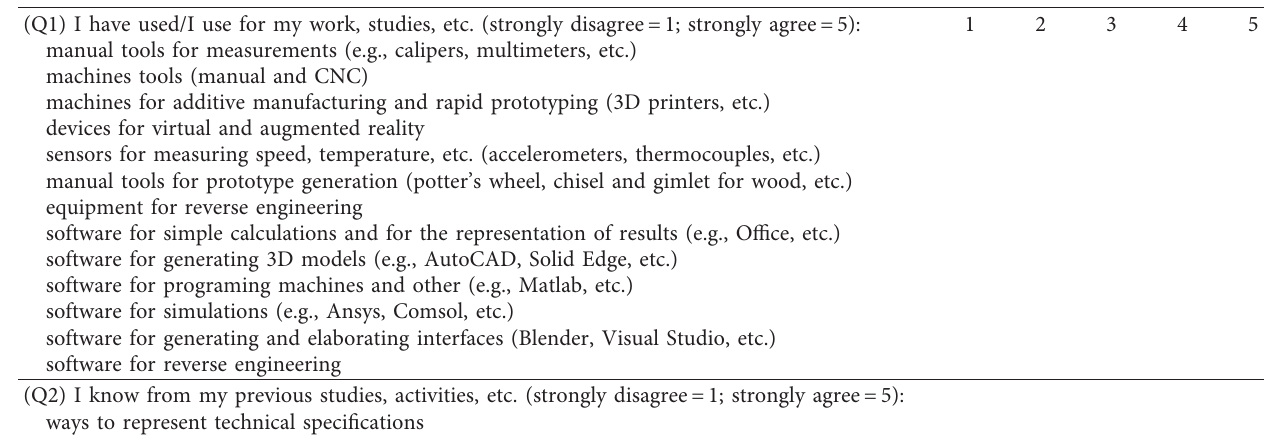
Table 7: The questionnaire used in the early DPE